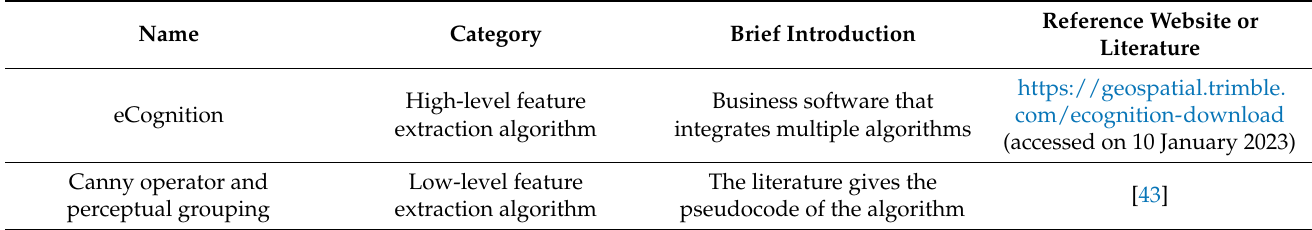
Table 11. Introduction to available algorithms